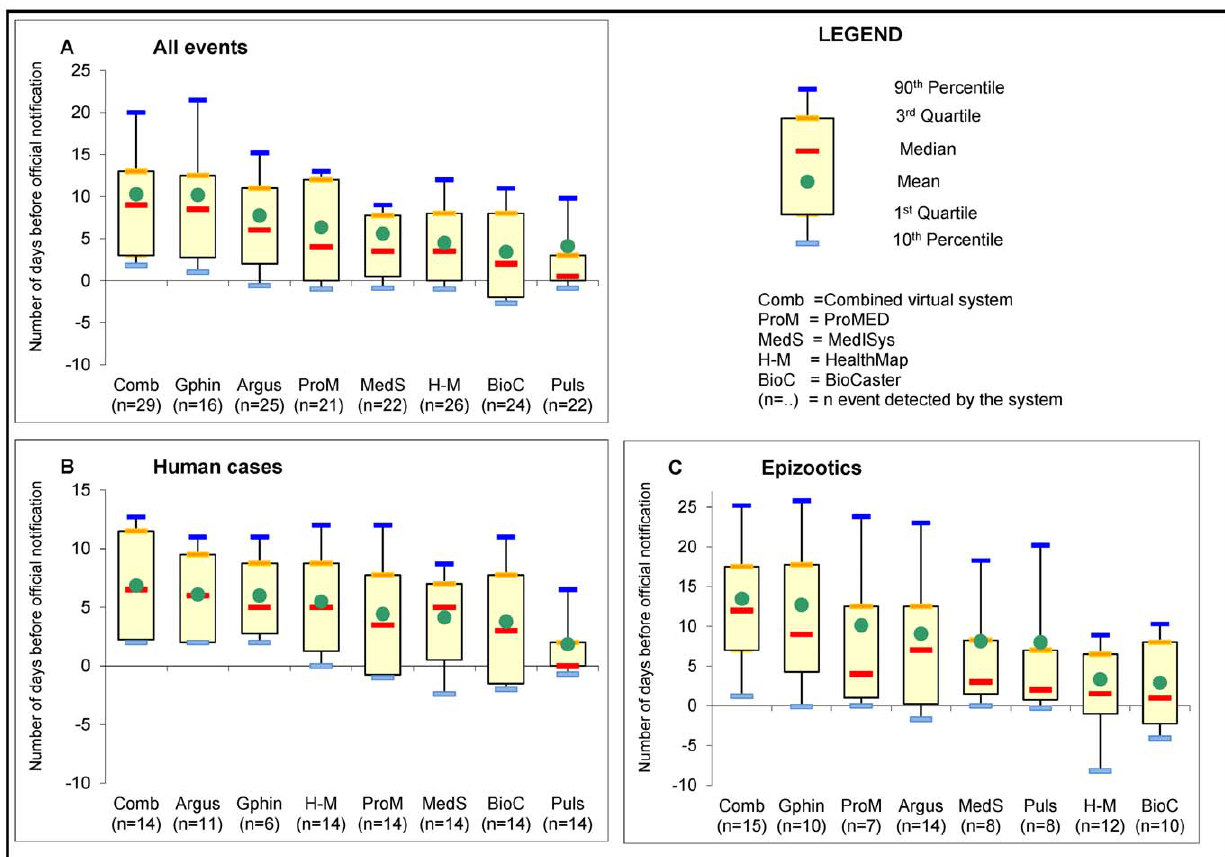
Figure 2. Timeliness of the systems for A/H5N1 cases (total, human, epizootic) reported in March 2010.